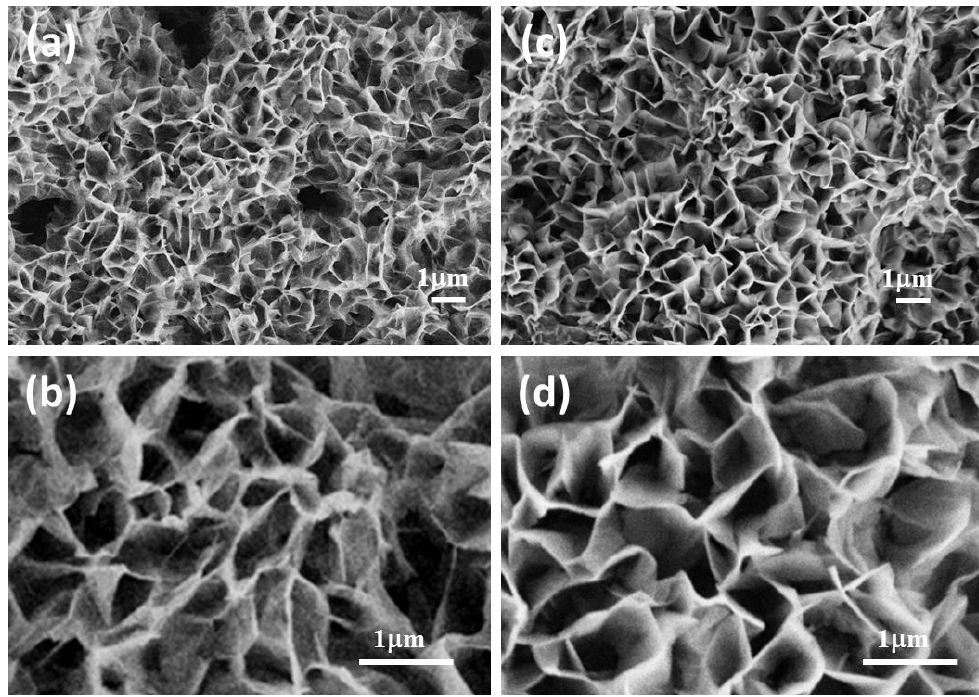
Figure 2. Scanning electron microscopy images of ( a , b ) as grown and ( c , d ) annealed sensing layer surfaces taken at different magnification.